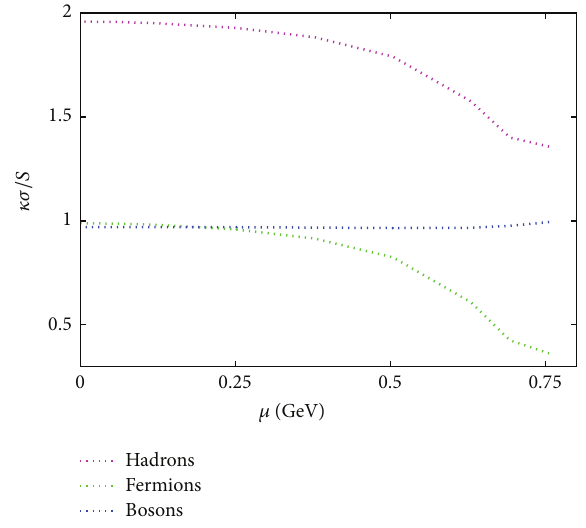
Figure 9: The dependence of 𝜅𝜎/𝑆 on the chemical potential 𝜇